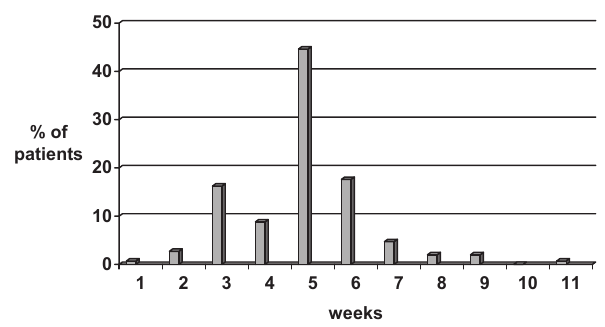
Fig. 2. – Percentage of patients (n = 148) with a confirmed diagnosis of trichinellosis showing different incubation periods (weeks).